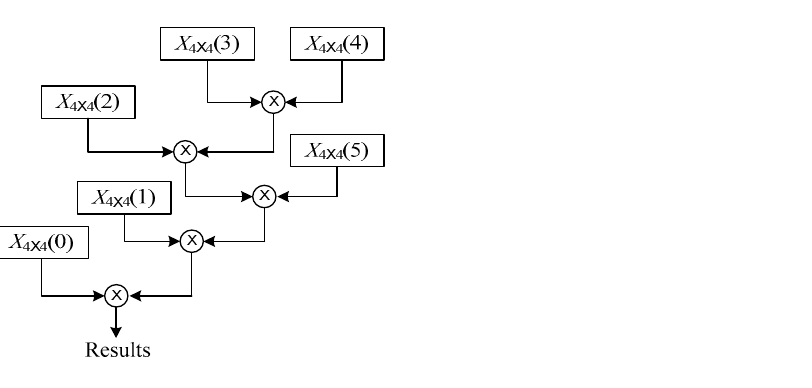
Figure 5. Example of the optimal order of the forward solution cascade multiplication of the homogeneous matrix.